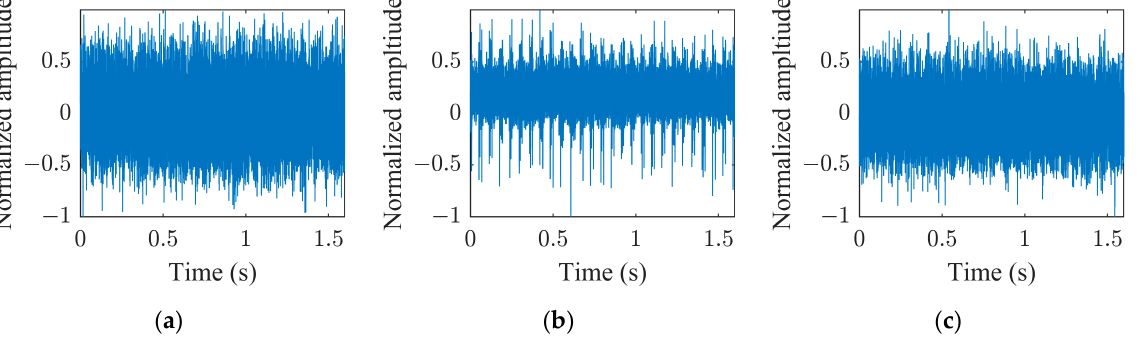
Figure 7. Vibration signal at 997 rpm and 124.8 kN radial load: ( a ) normal health state; ( b ) IR damage; ( c ) OR damage.